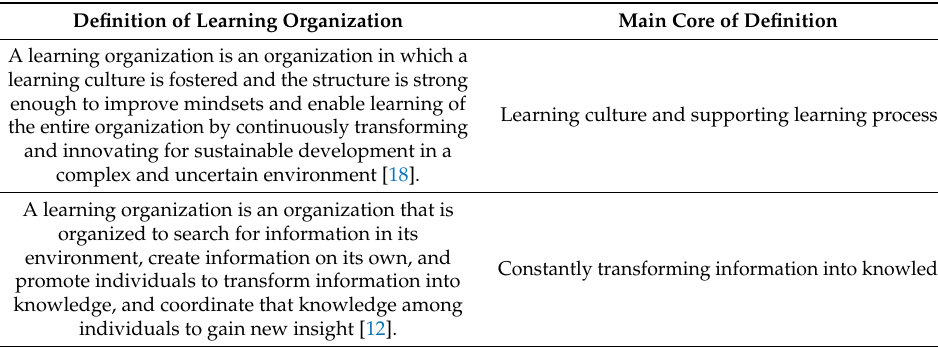
Table 1. Selected definitions of learning